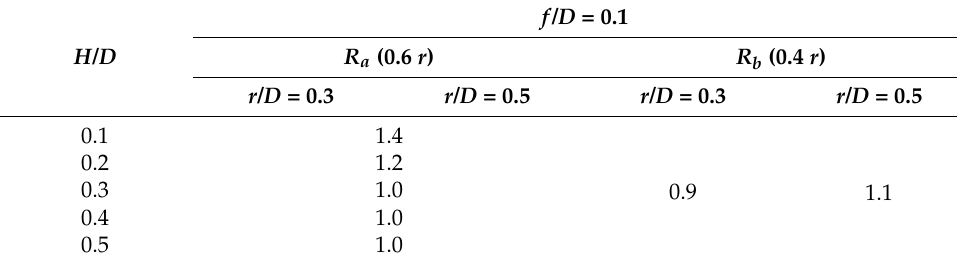
Table 12. Proposed positive peak net pressure coefficients.